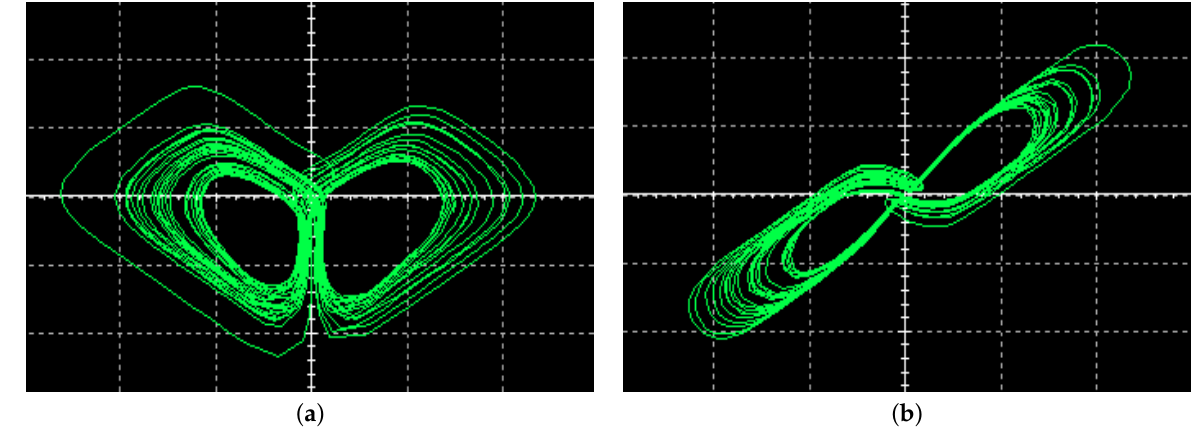
Figure 20. Phase portraits in Multisim of circuit: ( a ) X– Z plane; ( b ) X – Y